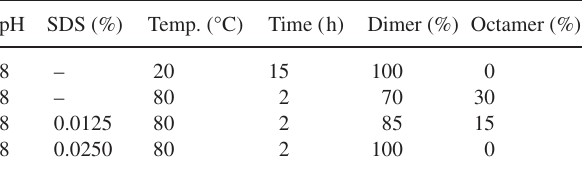
Table 3. Effects of temperature and SDS on the octamer–dimer equi- librium. Samples containing 30 µg of WT SSAM were incubated overnight at 20 °C in 100 µl of 20 mM sodium phosphate buffer pH 8.0 before analysis by GPC on a Superdex 200 column. One sample was heatedat80 °C for2 h and injectedontothecolumn.Two samples were heated at 80 °C for 2 h in the presence of 0.0125 or 0.0250 % SDS and injected onto the column.